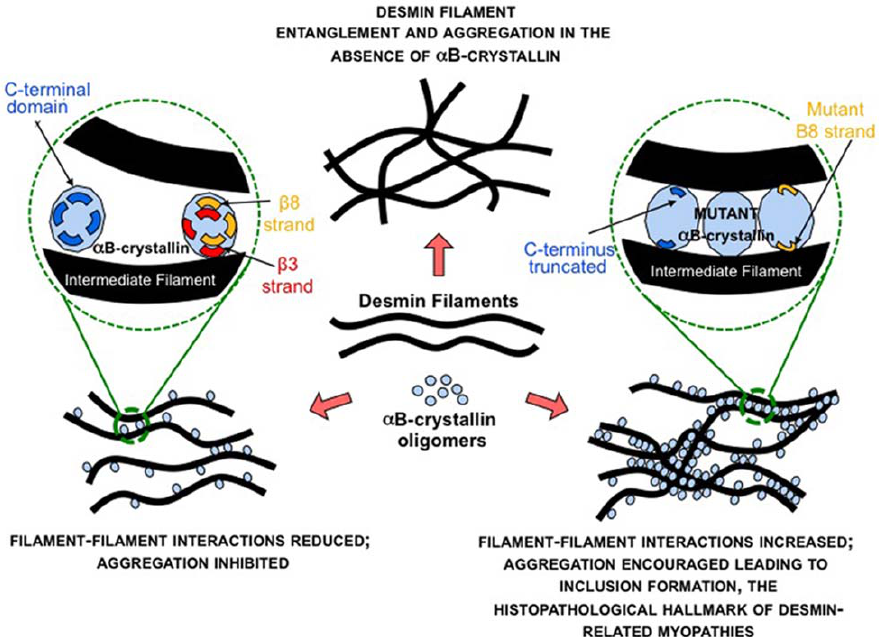
Figure 8. Summary of the influences of a B-crystallin on desmin filaments. The b 3- and b 8-strands and the D 155–165 sequences (C-terminal domain) in a B-crystallin were identified from peptide array studies as being desmin interaction sequences. In wild type a B-crystallin these sequences contribute to the interaction of the a B-crystallin oligomers with desmin filaments to prevent their self-association and the formation of filament- filament aggregates. This activity can be increased by substituting the b 3-strand from other small heat shock proteins ( a A-crystallin and C. elegans HSP12.2). Substituting the b 8-strand in a B-crystallin or removing the 155–165 residues appears to lead to the loss of this activity, but increases the binding of a B-crystallin to desmin filaments. This in turn will encourage increased filament-filament interactions, which in the case of the many point mutations in a B-crystallin linked to inherited myopathies, then leads to protein inclusion formation and the appearance of the histopathological feature of desmin-related myopathies – protein inclusions containing both desmin and a